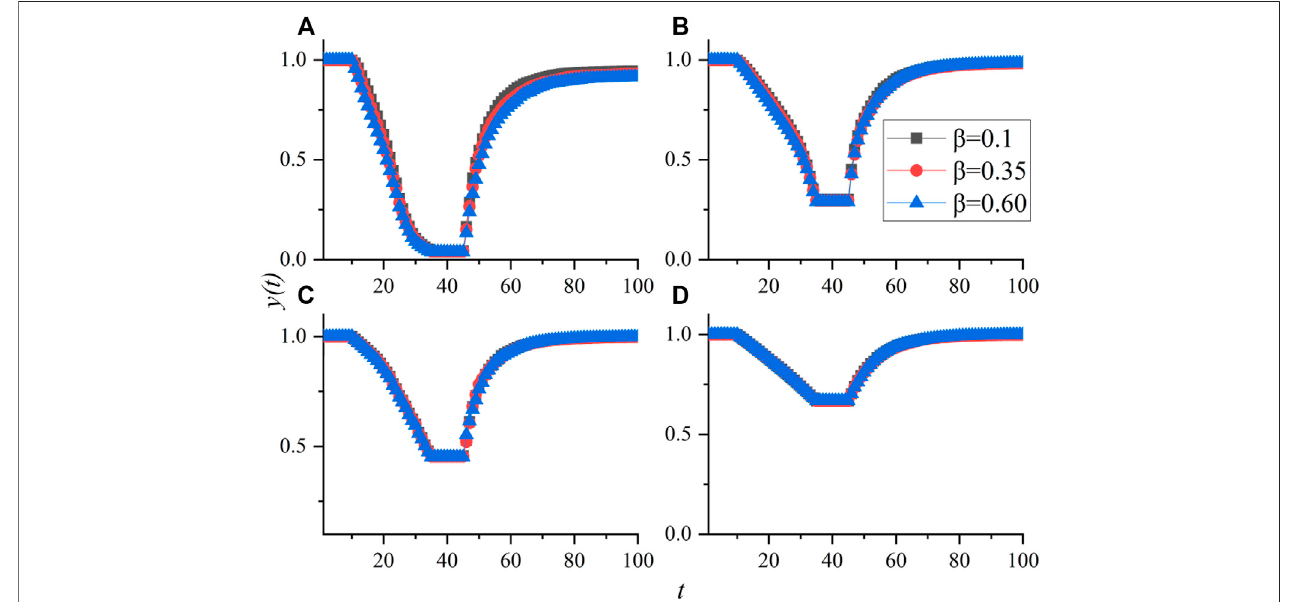
FIGURE 6 | In fl uence of parameter β on the resilience of the four networks. To re fl ect the difference, β is set to 0.1, 0.35, and 0.60, respectively. In addition, the remaining parameters η , and p are set to 0.1.